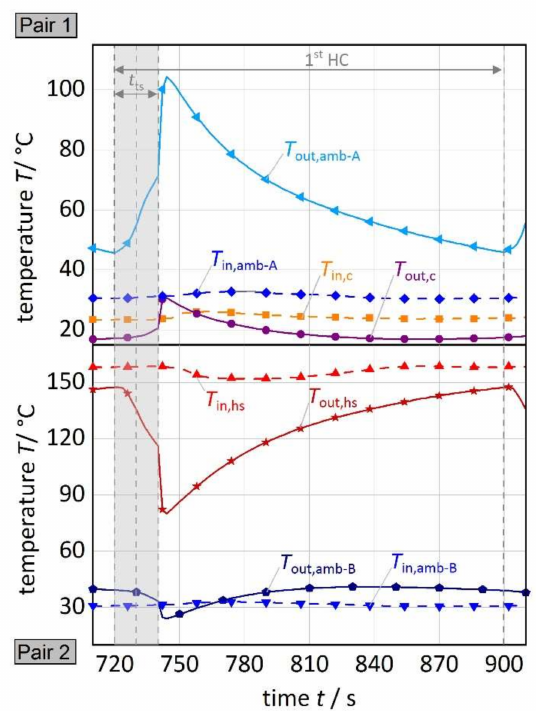
Figure 10. Top: transient course of the inlet and outlet temperatures of the ambient HTF loop and cooling HTF loop for reactor pair 1 for an exemplary 1st HC of the reference experiment between 720 and 900 s. Bottom: transient course of the inlet and outlet temperatures of the heat source HTF loop and ambient HTF loop for reactor pair 2 during the 1st